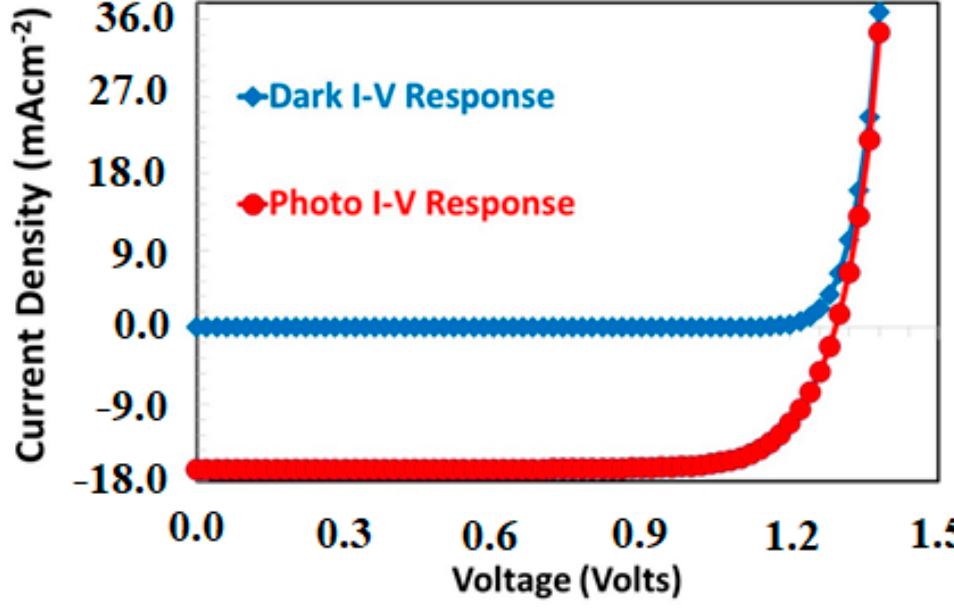
Figure 5. The simulated dark and AM 1.5 photovoltaic current responses of the proposed Ag/BCP/PCBM/Cs 2 TiBr 6 /NPB/ITO solar cell as a function of applied